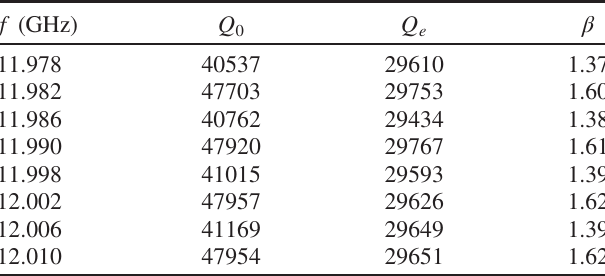
TABLE I. Unloaded Q-factor and coupling coefficient of correction cavities.